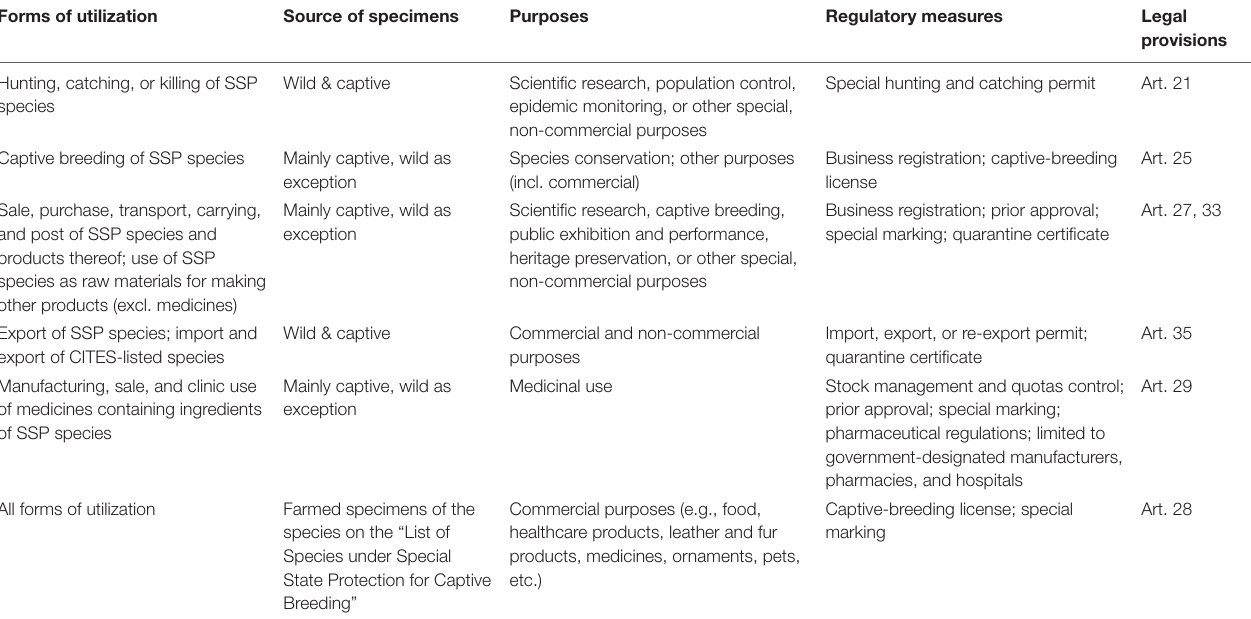
TABLE 1 | Permissible forms of utilization of species under special state protection (SPP), as stipulated in China’s Wildlife Protection Law